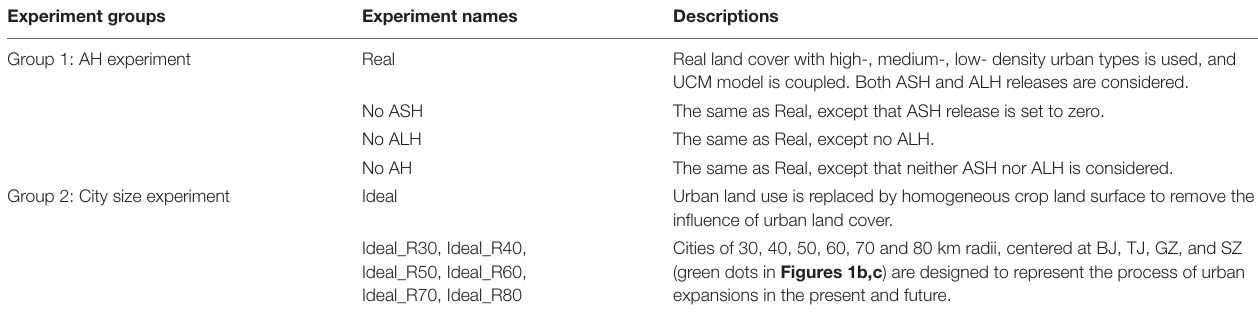
TABLE 4 | Experiment design and description in section “Experiment